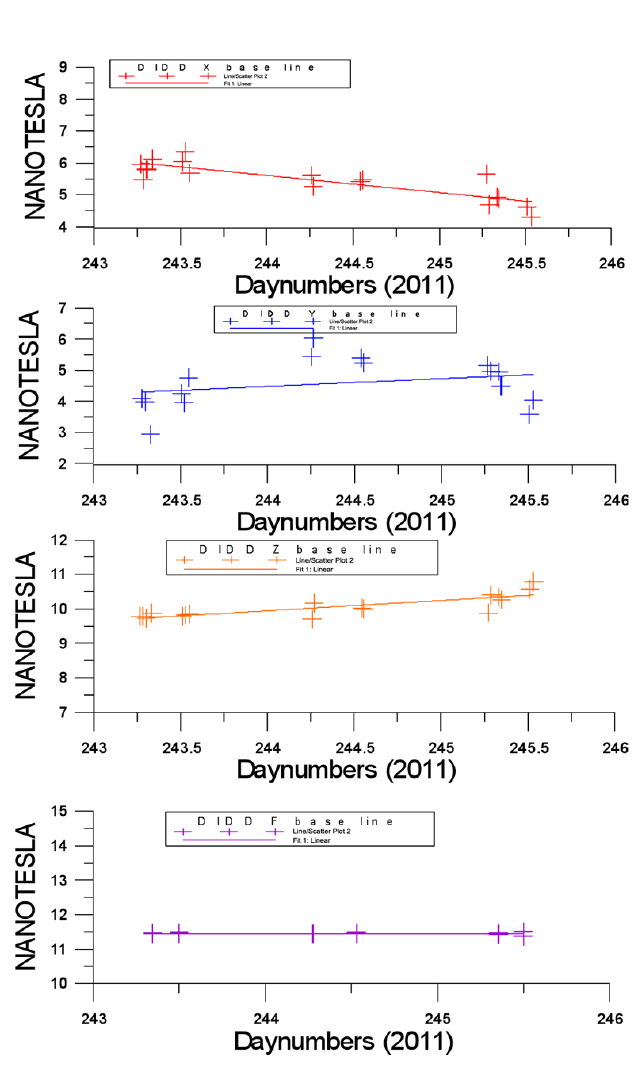
Figure 8. The adopted baseline of DIDD device in the Tihany